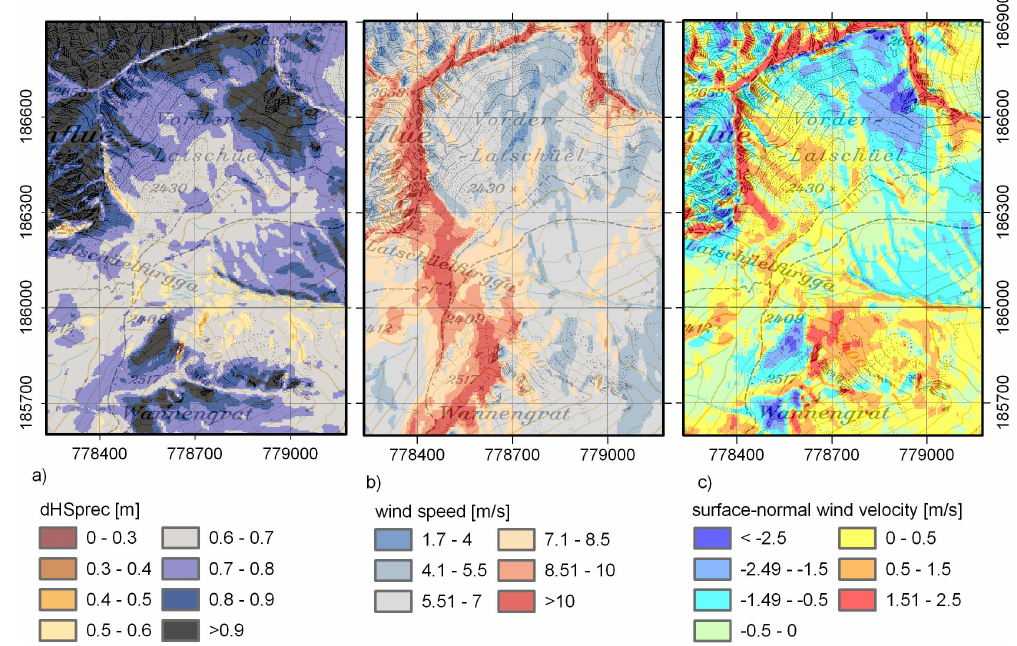
Fig. 14. Changes in snow depth (dHS prec ) due to preferential deposition of snow for P1 0809 (a) , wind velocity (b) and surface-normal wind velocity (c) . The x and y-axes give Swiss coordinates in meters. (basemap: Pixelkarte PK 25 ©2009 swisstopo (dv033492)).